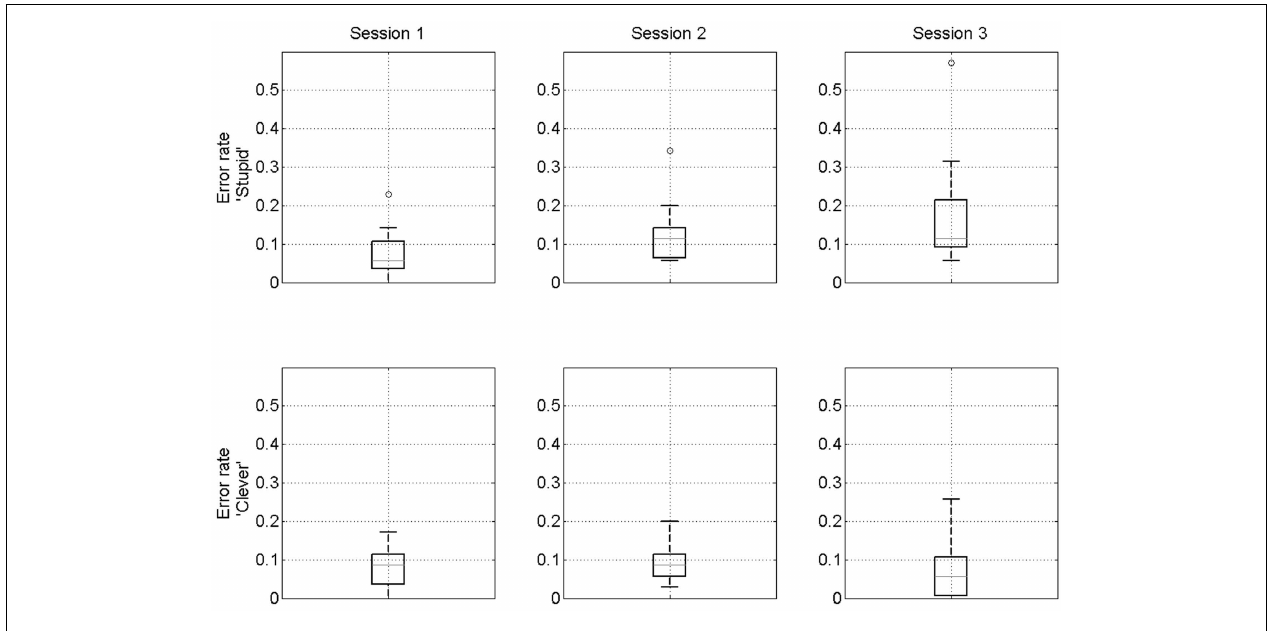
percentiles, the whiskers extend to the most extreme data points considered not to be outliers, and outliers are plotted individually.The outlying data points in the top row are all from participant